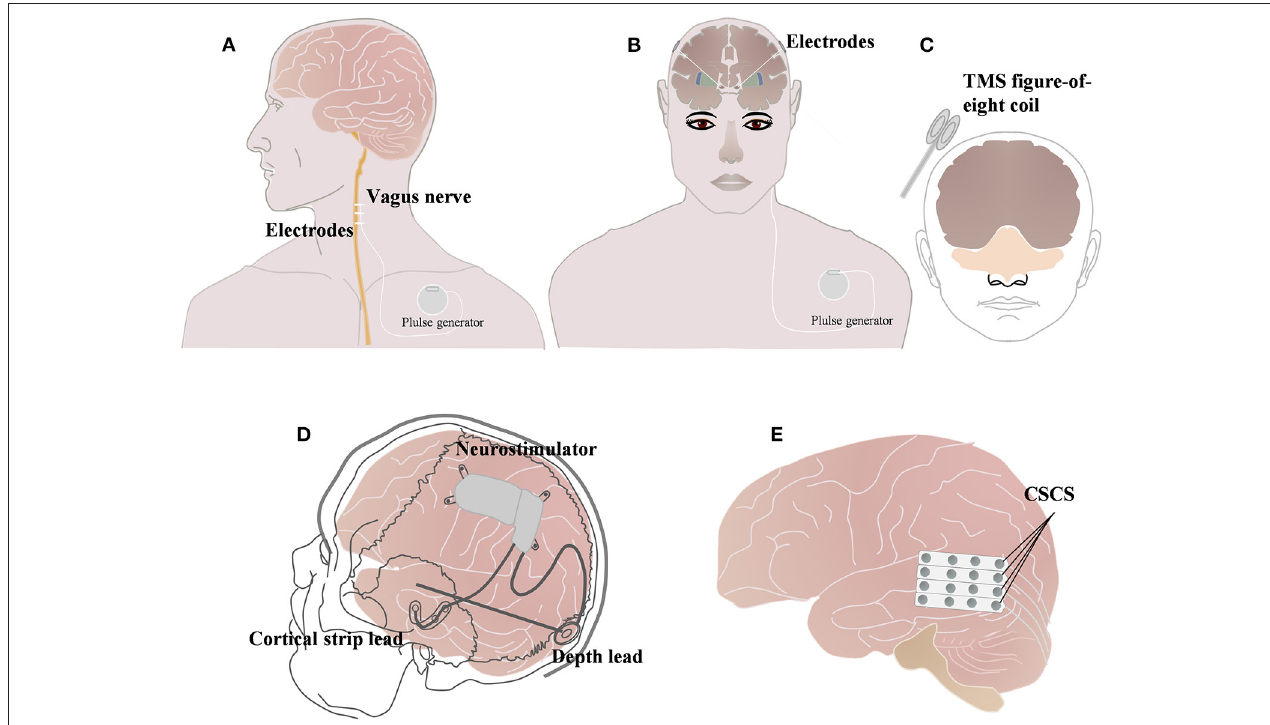
FIGURE 2 | Brief schematic diagram of three neuromodulation techniques commonly used in Dravet syndrome. (A) Vagus nerve stimulation (VNS); (B) Deep brain stimulation (DBS); (C) Transcranial magnetic stimulation (TMS). (A) Vagus nerve technique (VNS); (B) Deep brain stimulation (DBS); (C) Repetitive transcranial magnetic stimulation (rTMS) (13); (D) Responsive neurostimulation (RNS) (18); (E) and chronic subthreshold cortical stimulation (CSCS) (20).